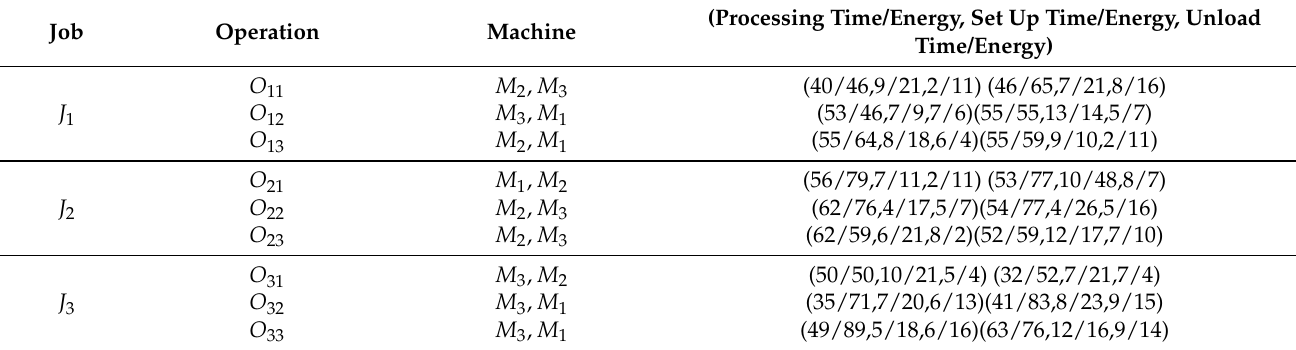
Table 1. The processing information of the instance mentioned before (unit: min/kWh). Job